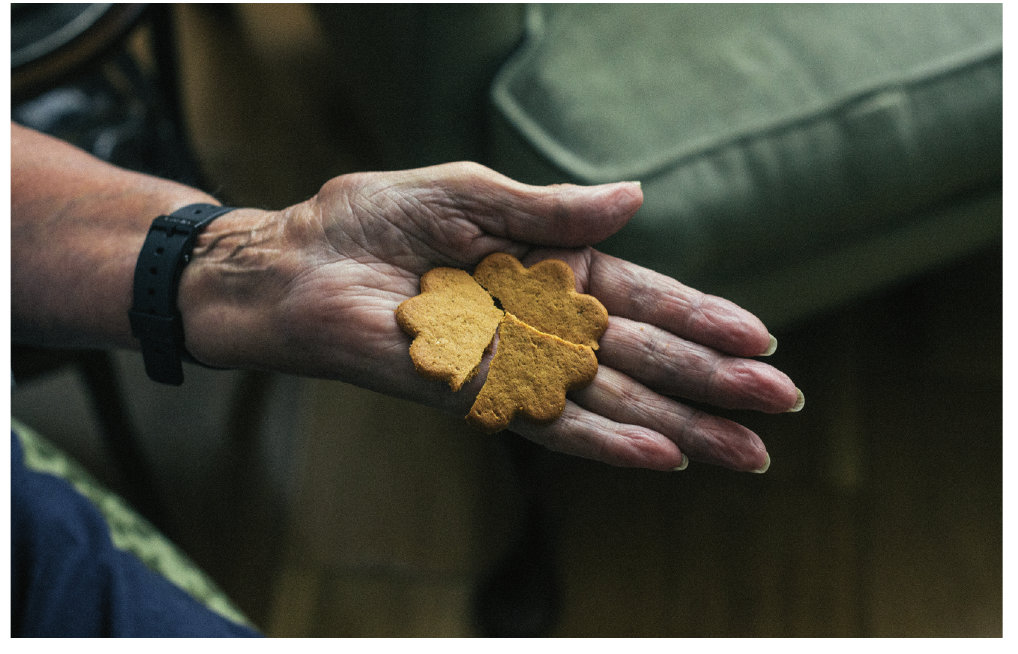
Figure 8: Breaking the biscuit: A Swedish custom; from the series ‘A Great Wish’